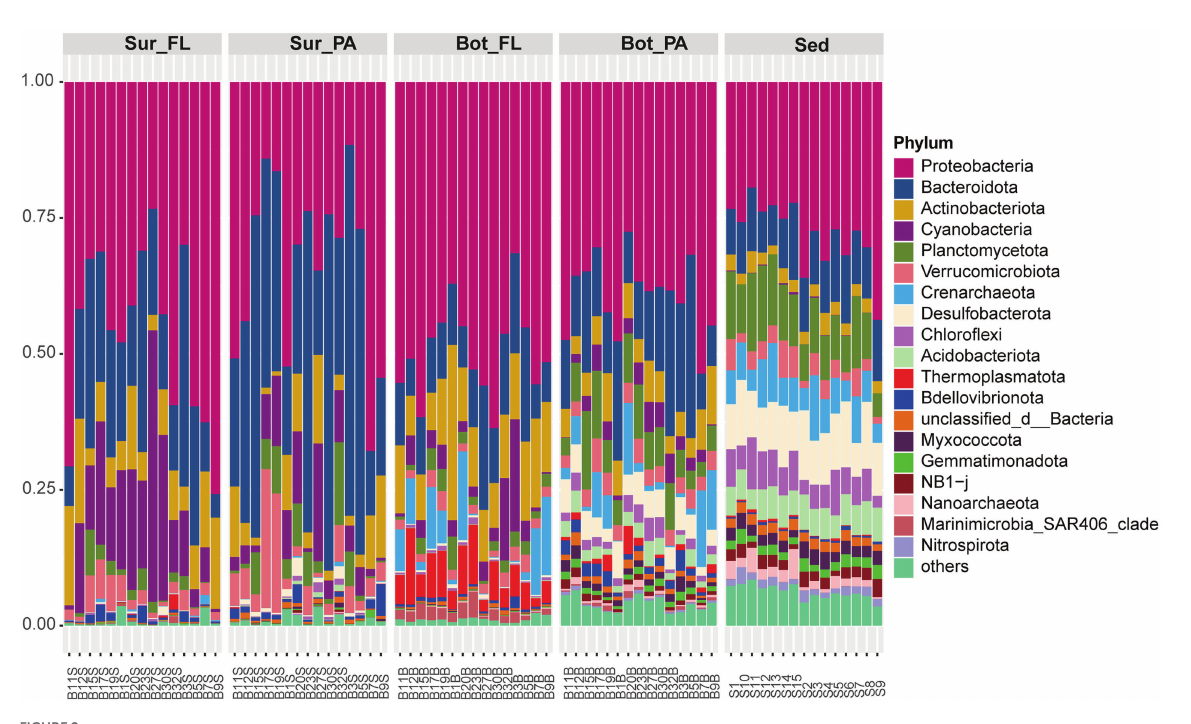
FIGURE 2 Composition of microbial communities at the phylum level. Sur_FL, FL community in surface water; Sur_PA, PA community in surface water; Bot_ FL, FL community in bottom water; Bot_PA, PA community in bottom water; Sed, sedimentary